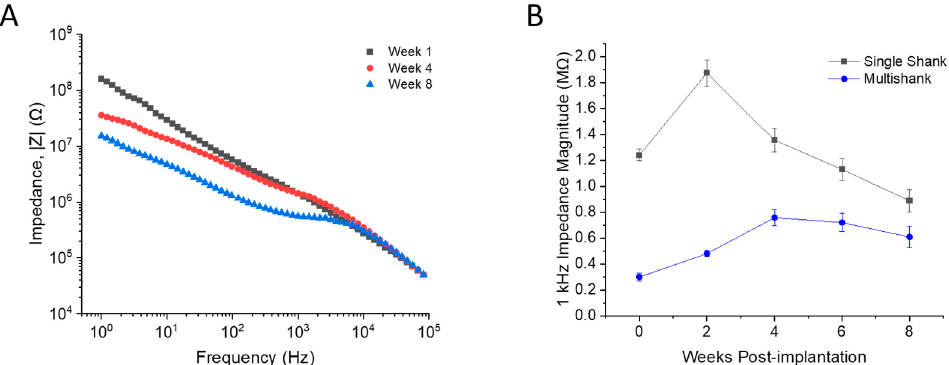
Figure 4. Electrochemical impedance spectroscopy. ( A ) Impedance magnitude for a representative single shank microelectrode at Weeks 1, 4, and 8. ( B ) Impedance magnitude at 1 kHz for single shank (black) and multi-shank (blue) devices. Data presented as mean ± SEM.